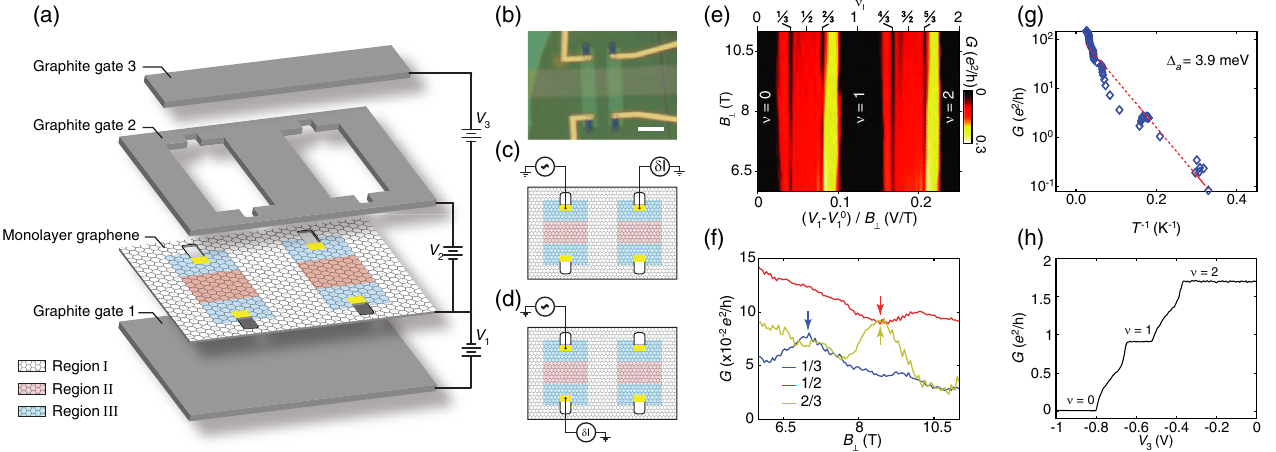
FIG. 8. Charge transport measurement on device A. (a) Device geometry. (b) Optical micrograph of the sample. Scale bar represents 5 μ m. (c) Schematic of the interisland transport measurement. (d) Schematic of the intraisland transport measurement. (e) Bulk conductance versus carrier density and magnetic field between ν ¼ 0 to ν ¼ 2 , measured in the configuration of (c). (f) Line cuts of (e) along vertical axis at ν ¼ 1 = 3 , 1 = 2 , and 2 = 3 . Phase transitions at ν ¼ 1 = 3 ; 2 = 3 and the incompressible state at ν ¼ 1 = 2 are marked by arrows. (g) Arrhenius plot of the conductance at the charge neutrality point; linear fitting of the data shows the sample is insulating with an energy gap of 3.9 meV. (h) A typical trace of intraisland conductance as a function of V 3 measured in the configuration of (d). 0 and ν 2 V 1 ¼ 0 . 6131 V. V 2 ¼ − 0 . 4717 V. This combination of V 1 and V 2 ensures ν I ¼ III ¼